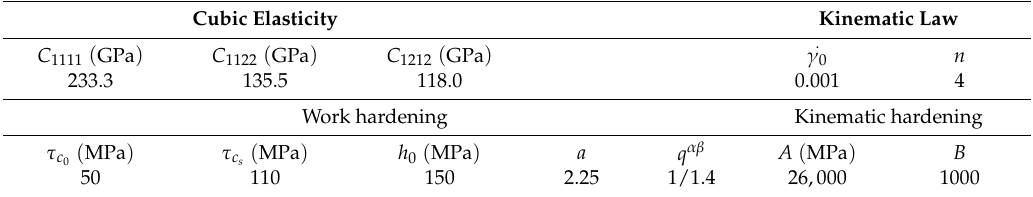
Table 4. Finite element analysis parameters of ferrite. Elastic coefficients are taken from the literature